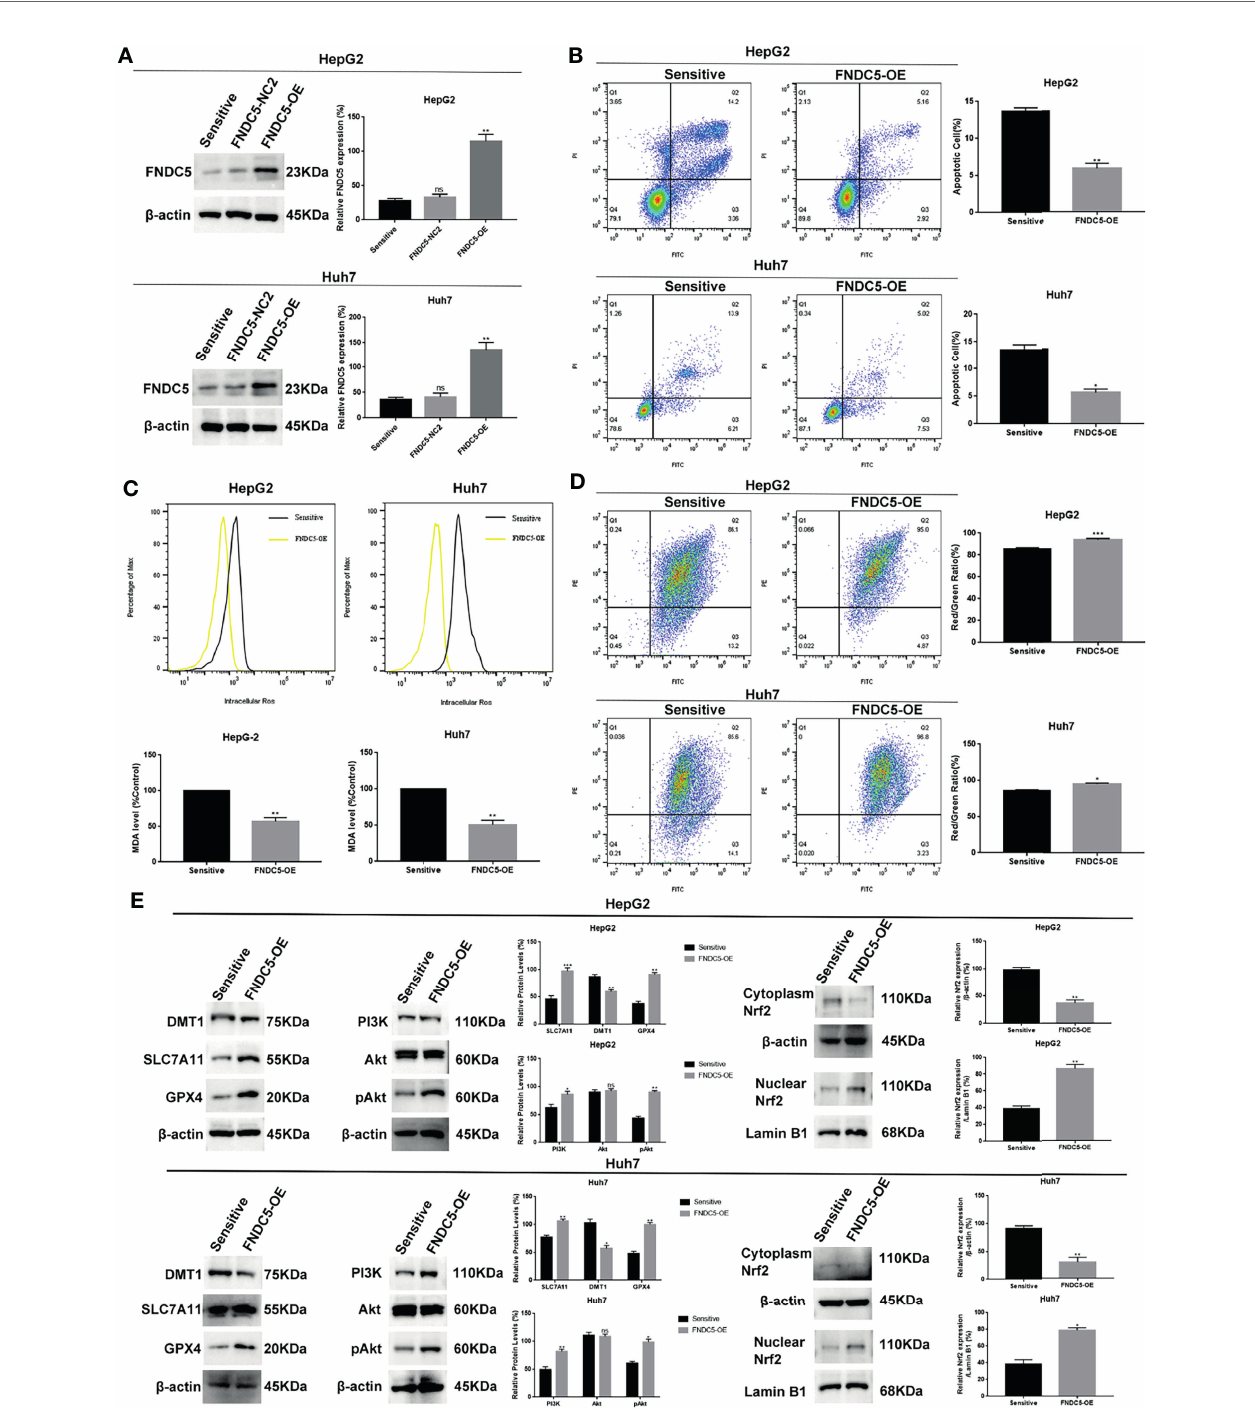
FIGURE 6 | Overexpression of FNDC5 reduces the sensitivity of HCC cells to sorafenib. (A) A lentiviral vector was used to overexpress FNDC5; western blotting was performed to verify the overexpression effect. (B) After treatment of sorafenib-sensitive HCC and FNDC5-overexpressing HCC cell lines with sorafenib (10 µM) for 24 h, fl ow cytometry was used to detect the apoptotic rates in both groups. (C) ROS and MDA assays were performed to compare the level of ferroptosis between the groups. (D) Flow cytometry analysis of alterations in mitochondrial membrane potential in both groups. (E) Western blotting for detecting the expression levels of ferroptosis markers and Nrf2-associated pathway proteins in both groups of cells. *Compared with the sorafenib-sensitive HCC cells, *p < 0.05, **p < 0.01, ***p < 0.001. ns, no signi fi cant